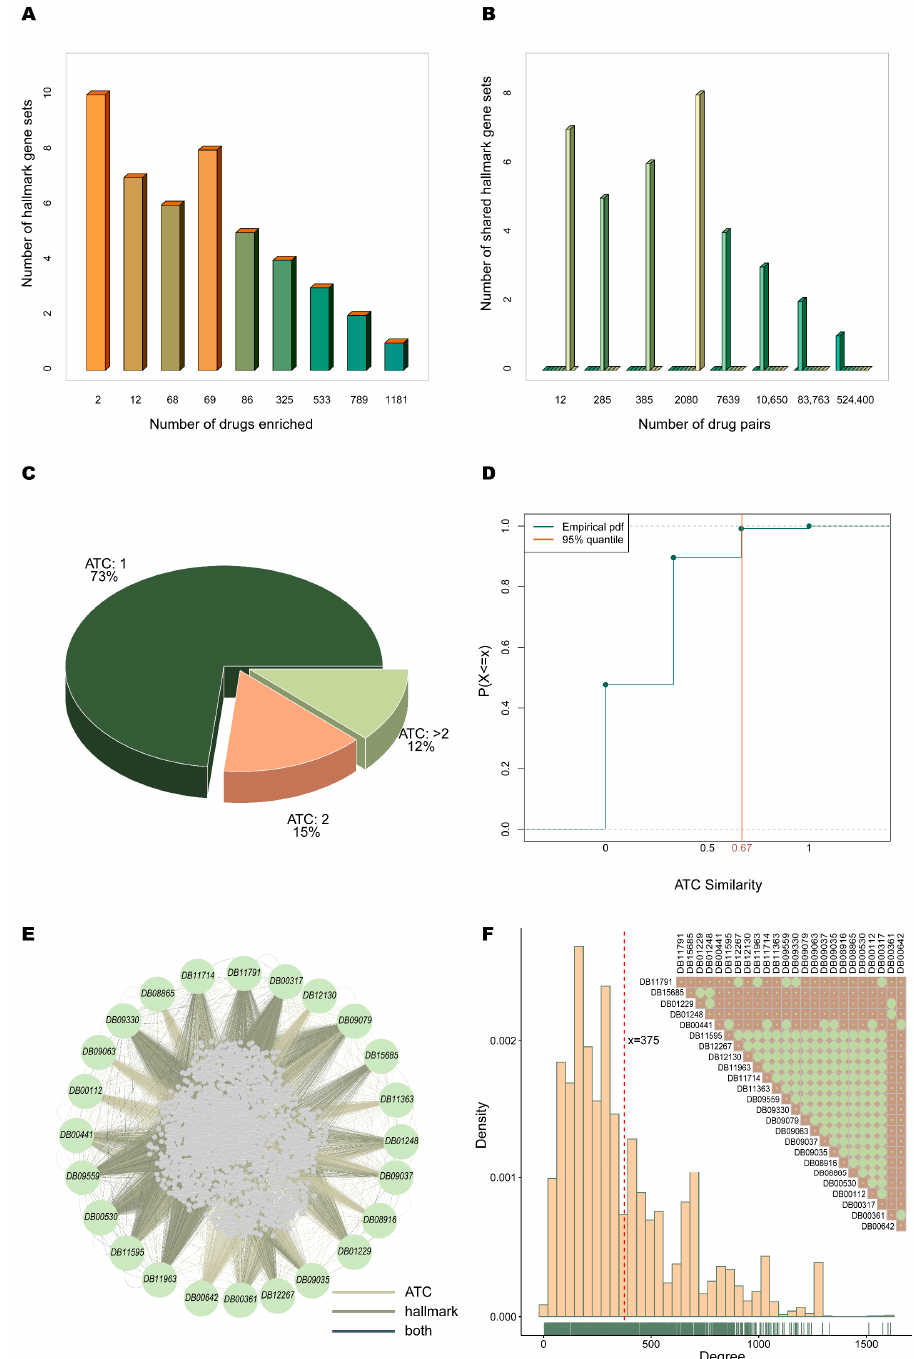
Figure 1. Cancer-related drug similarity network. ( A ) Number of hallmark gene sets that the drug is enriched to. ( B ) Number of hallmark gene sets shared by drug pairs. ( C ) Percentage of drugs with corresponding number of ATC codes. ( D ) Empirical probability distribution of clinical therapeutic similarity values. The orange vertical line represents the 95th percentile of similarity data with a value of 0.67. ( E ) Graph of the network (green nodes represent known treatments for NSCLC, the color of the edge represents the source of similarity). ( F ) Density plot of node degrees in the network. The carpet margin line represents the density of the distribution of data on the axes, and the red vertical line represents the mean of all node degrees with a value of 375. Additionally, the similarity plot between known therapeutic drugs of NSCLC is inserted, with bright green circles representing having